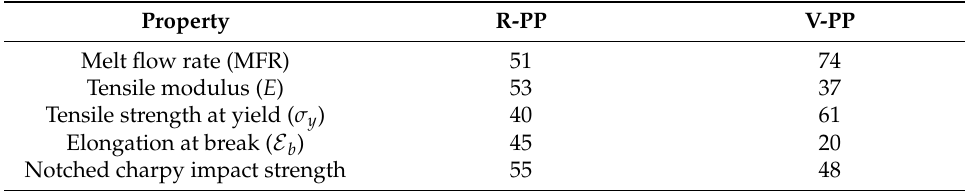
Table 2. Data and number of values